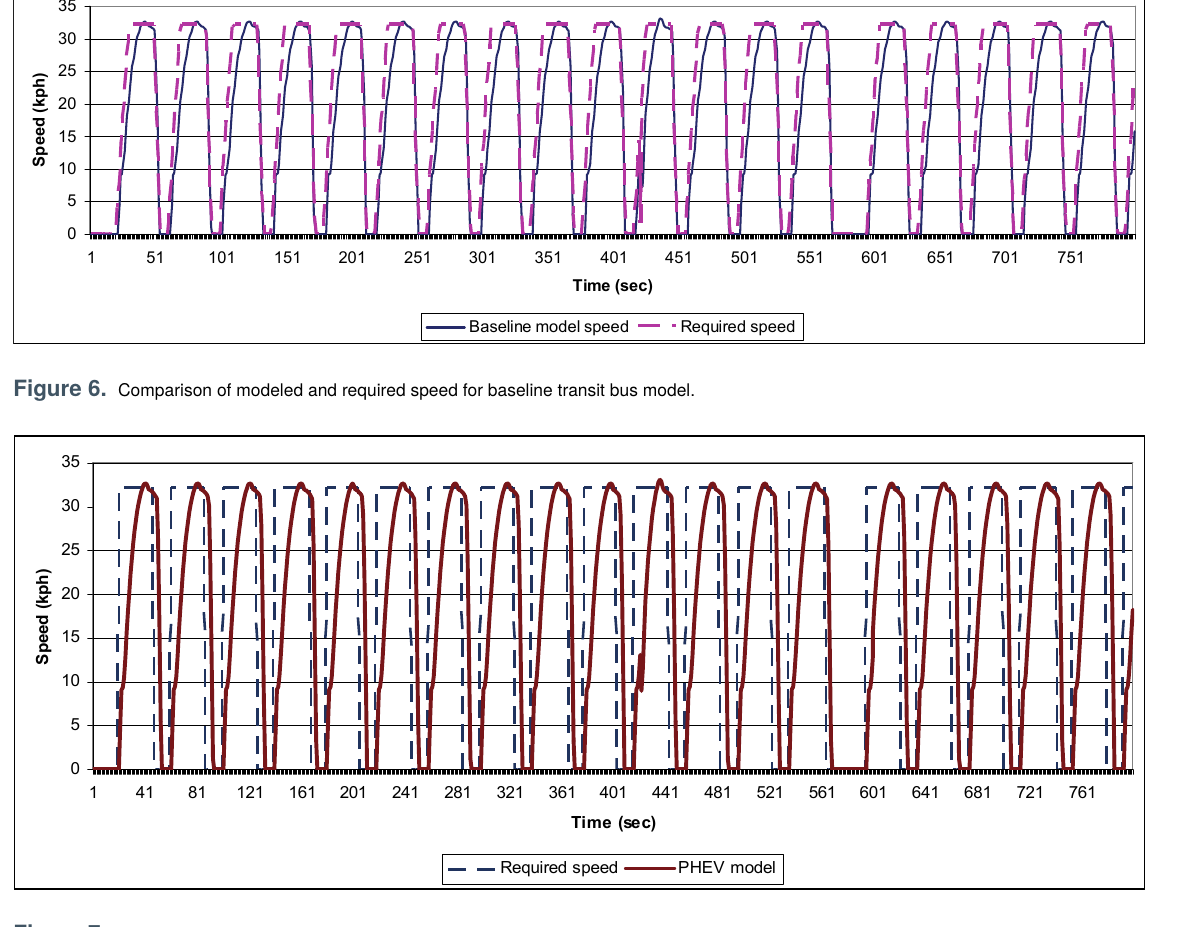
Figure 7. Comparison of modeled and required speed for PHEV model.